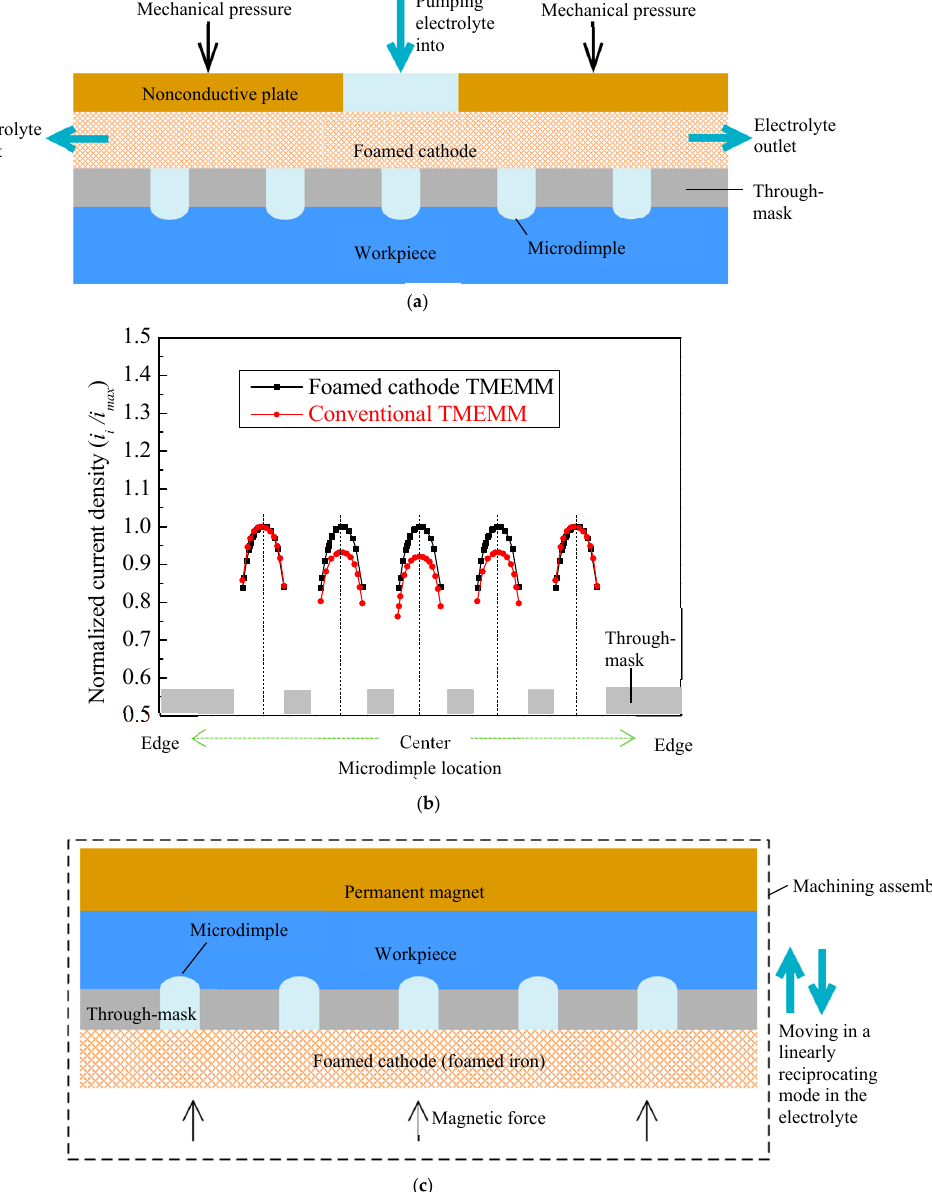
Figure 1. Schematic diagram of the foamed cathode through mask electrochemical micromachining (TMEMM) process with di ff erent through-mask fixture manner and mass transfer methods. ( a ) Pressed by the mechanical force, driven by the pump; ( b ) theoretical current distribution within the machined area and across the entire workpiece; ( c ) pressed by the magnetic force, driven by mechanical motion.